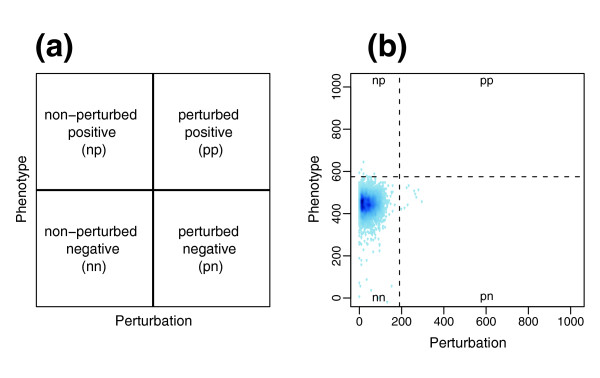
Setup of boundaries. (a) Discretization of data showing binary response in four subtypes. (b) Mock control used for setup of boundaries.